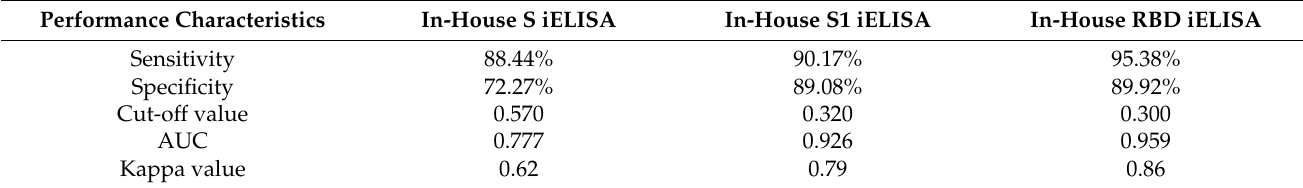
Table 3. Performance characteristics of the in-house S, S1 and RBD iELISAs.